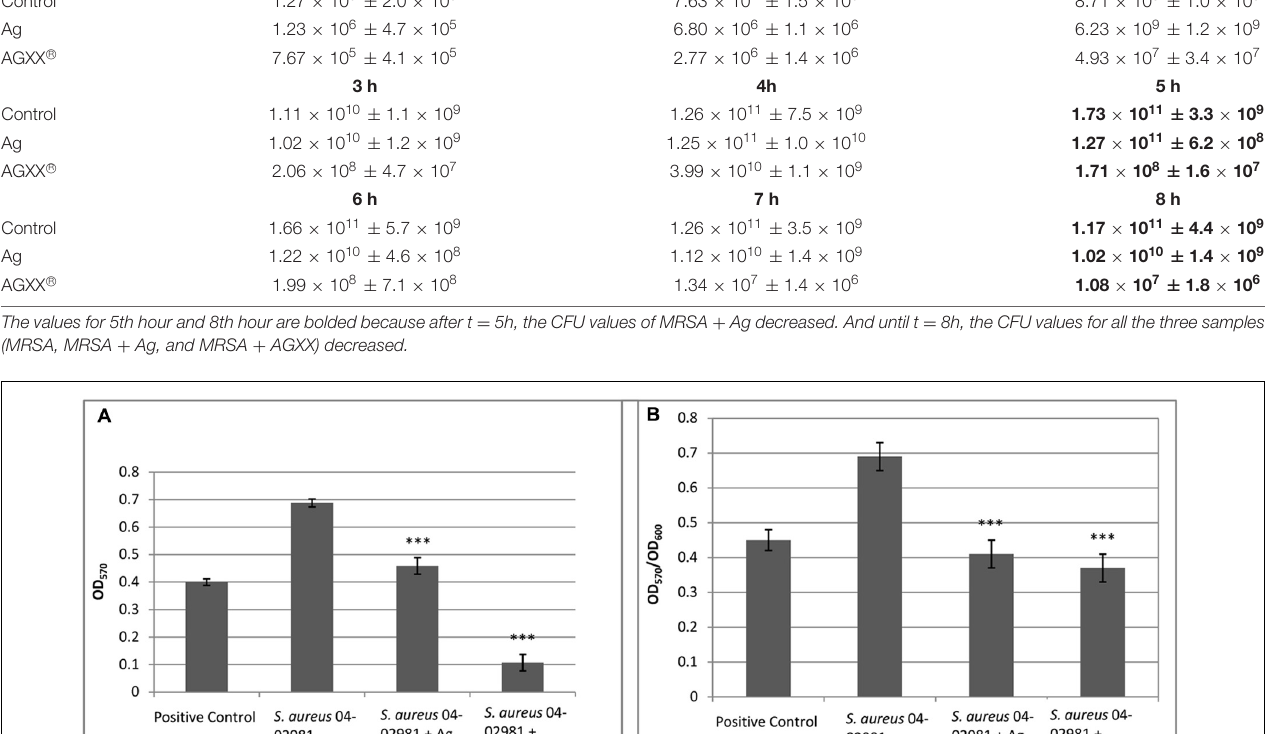
TABLE 1 | Colony forming units (CFU)/mL of Staphylococcus aureus 04-02981 (without sheet = control), in the presence of AGXX R (cid:13) or Ag. Sample